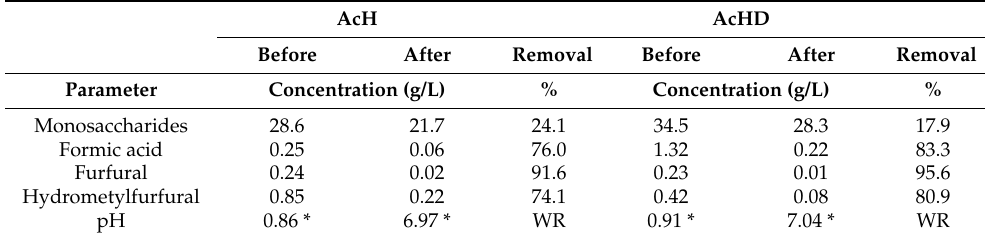
Table 4. Composition of acid hydrolyzates before and after ion-exchange treatment.